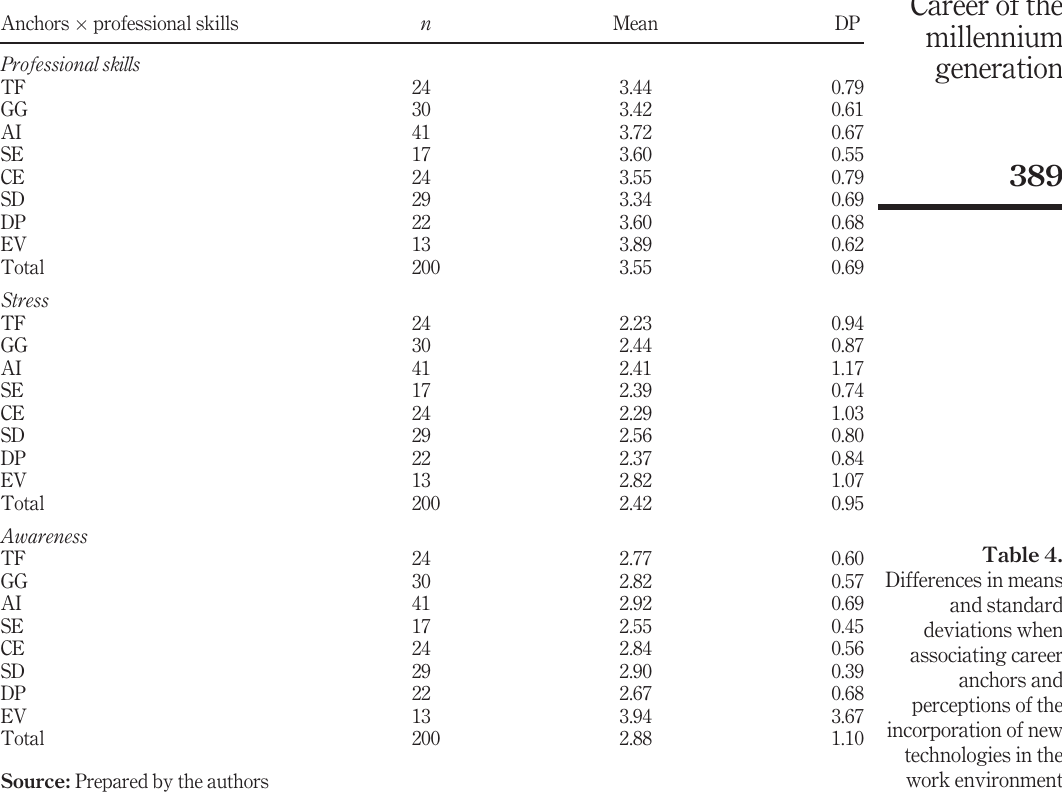
Table 4. Differences in means and standard deviations